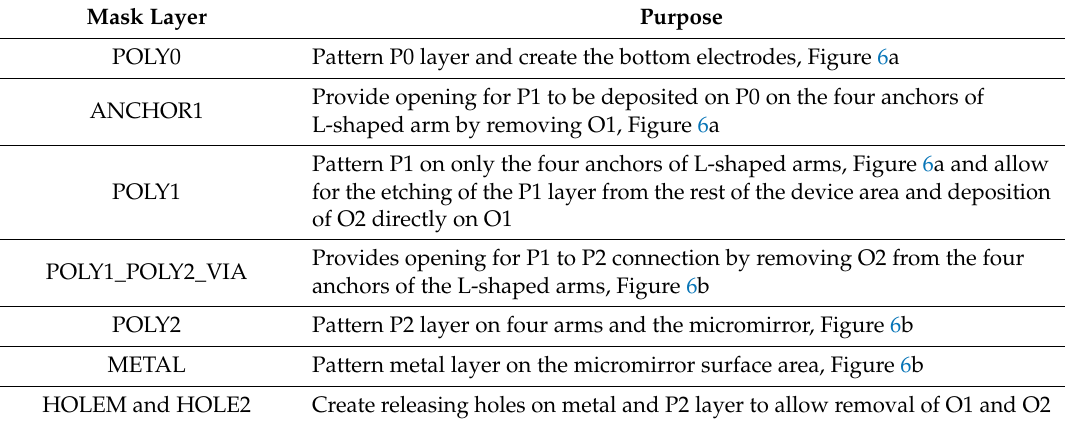
Table 2. Employed mask layers and their purposes in the PolyMUMPs fabrication technique. Mask Layer Purpose POLY0 Pattern P0 layer and create the bottom electrodes, Figure 6a Provide opening for P1 to be deposited on P0 on the four anchors of ANCHOR1 L-shaped arm by removing O1, Figure 6a Pattern P1 on only the four anchors of L-shaped arms, Figure 6a and allow POLY1 for the etching of the P1 layer from the rest of the device area and deposition of O2 directly on O1 Provides opening for P1 to P2 connection by removing O2 from the four POLY1_POLY2_VIA anchors of the L-shaped arms, Figure 6b POLY2 Pattern P2 layer on four arms and the micromirror, Figure 6b METAL Pattern metal layer on the micromirror surface area, Figure 6b HOLEM and